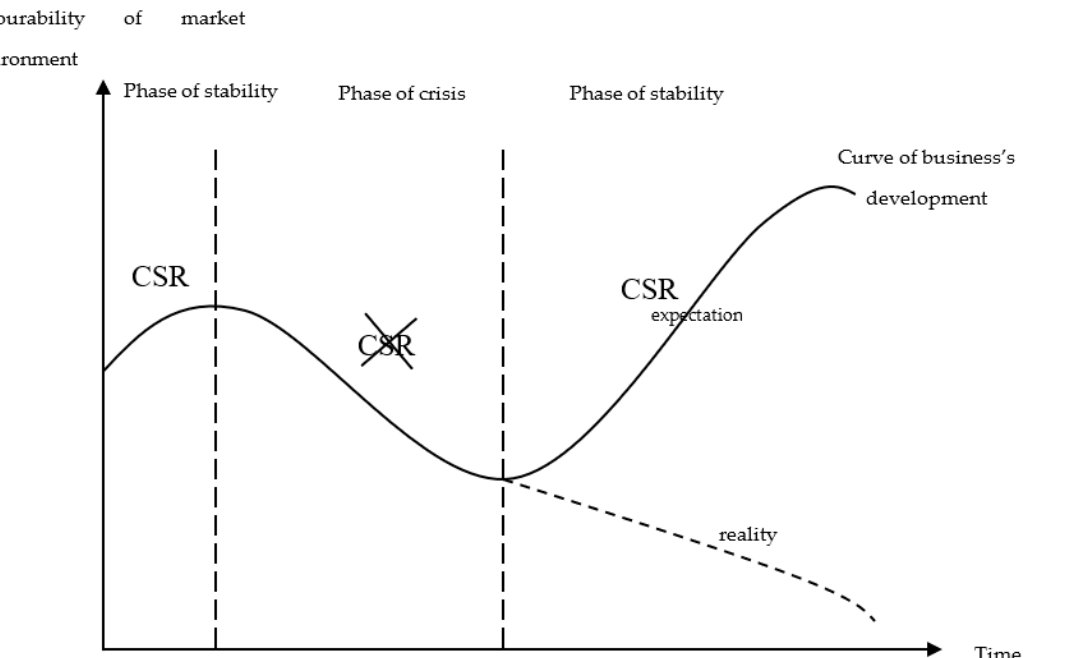
Figure 1. Cyclicity of managing financial business risks according to the traditional commercial approach. Note: CSR—corporate social responsibility. Source: Authors.